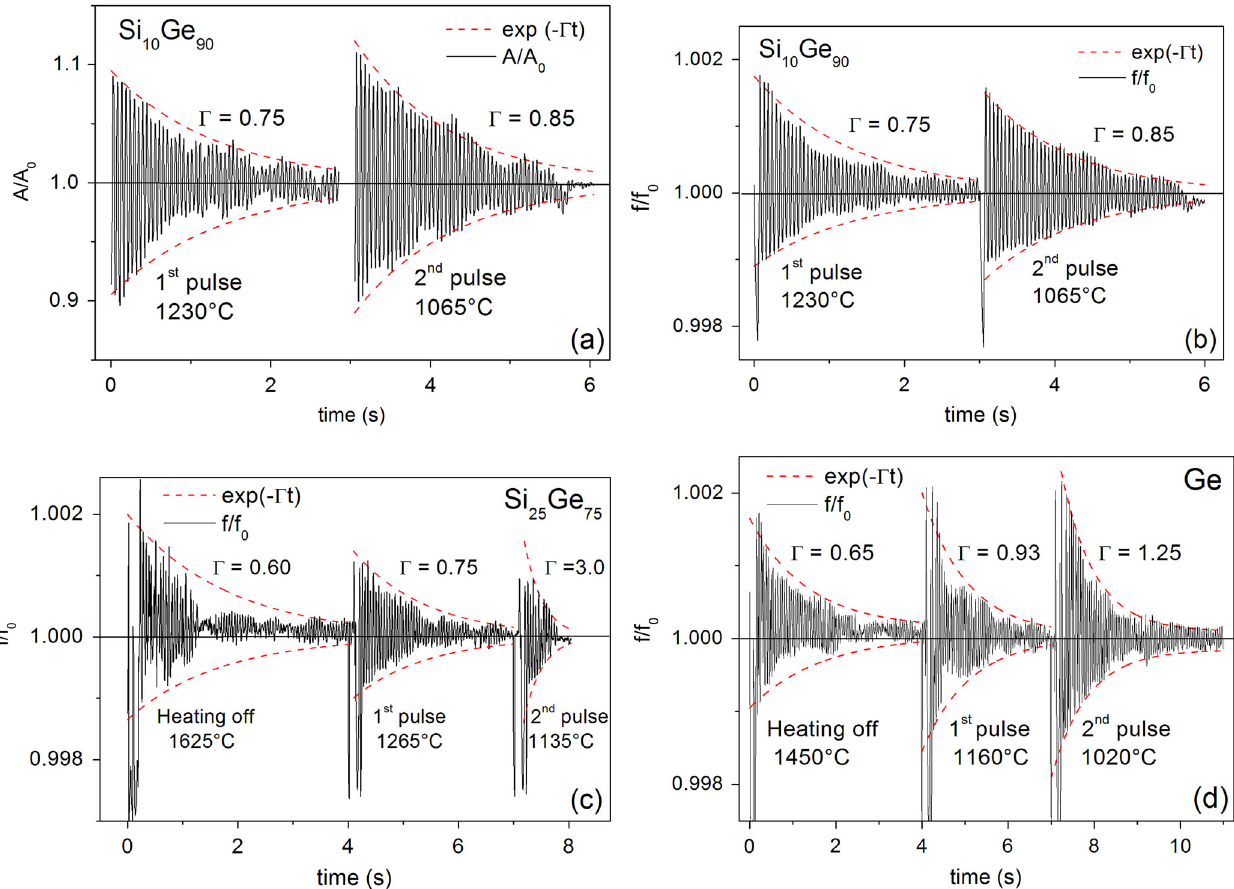
Fig. 4 Oscillations of optic ( a ) and electronic ( b ) data measured for the Si 10 Ge 90 drop with triangular pules (8 V, 50 ms), as well as electronic data for the Si 25 Ge 75 ( c ), and Ge ( d ) drops with rectangle pulses (7 V, 100 ms), including fi ttings ( red dashed lines ) with an exponential